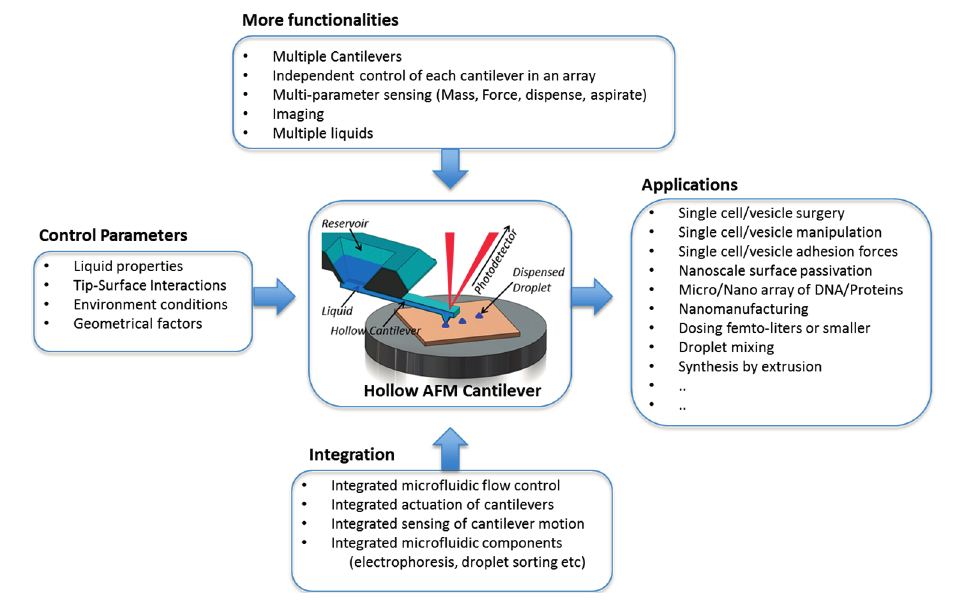
Figure 27. By integrating various in-situ capabilities, gaining access over many control parameters and integrating more functionality onto the hollow AFM cantilever the device can be applied to numerous